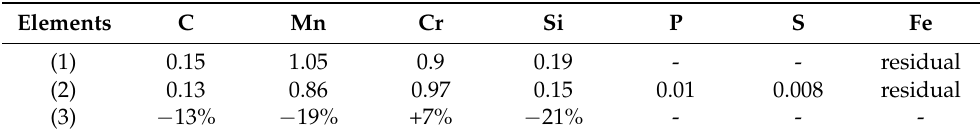
Table 2. Comparison of chemical composition showing carbon depletion (1) powder, wt.% (2) build material, wt.% (3) percentage change; rem: